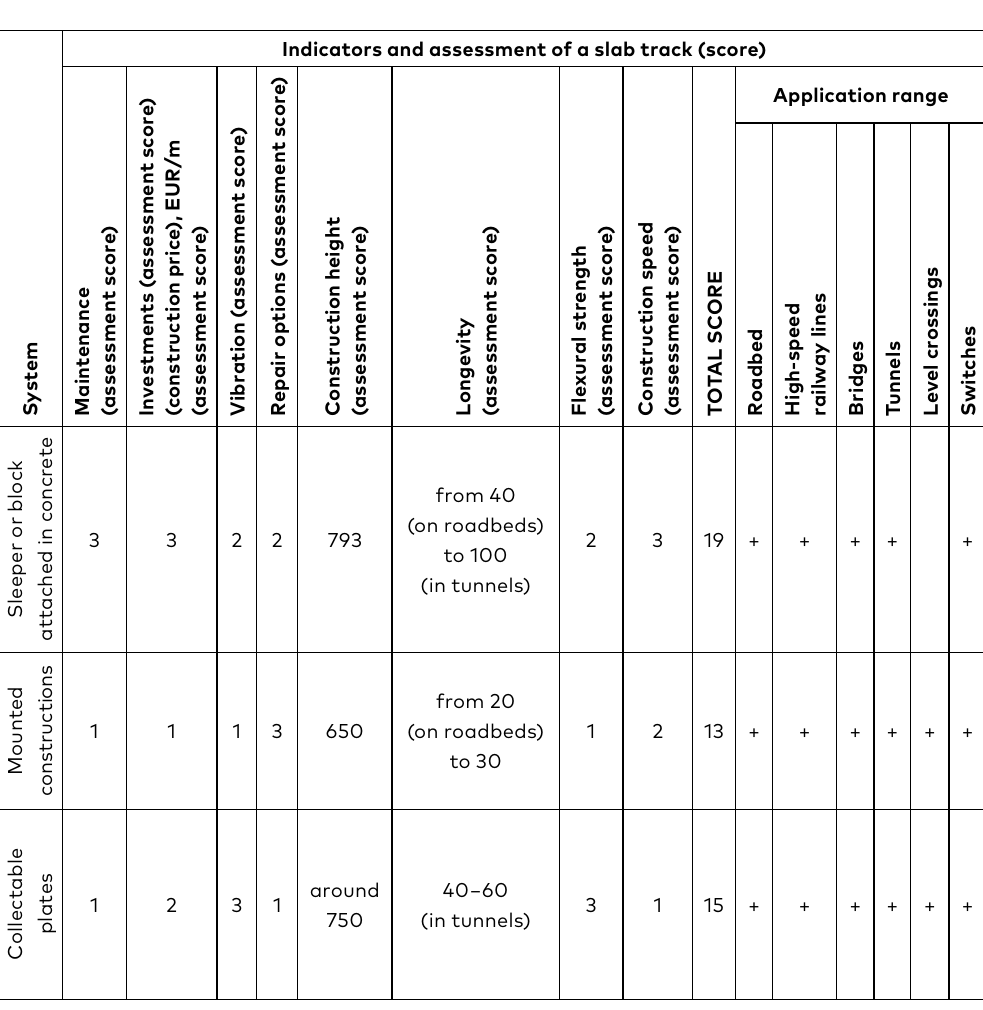
Table 3. Technical and operational indicators of slab track constructions and their assessment Indicators and assessment of a slab track